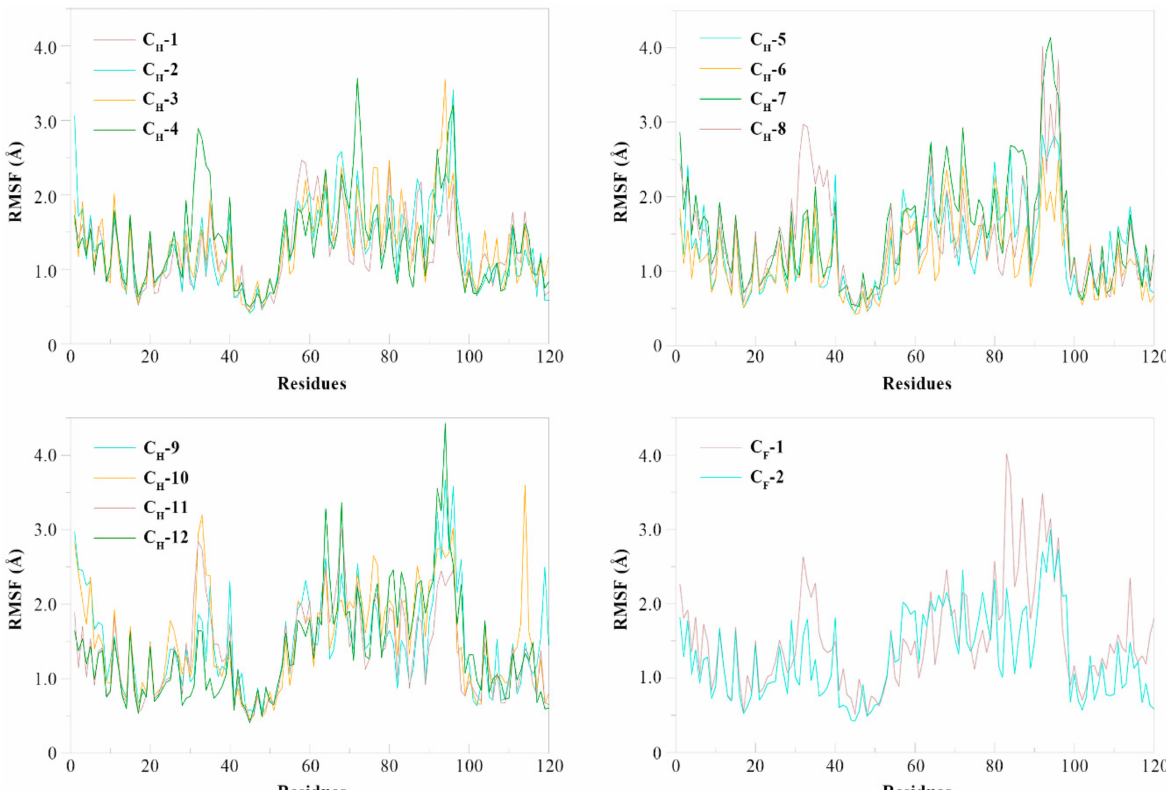
Figure 4. Residue fluctuations for SnocOBP12–ligand complexes during the 50 ns MD